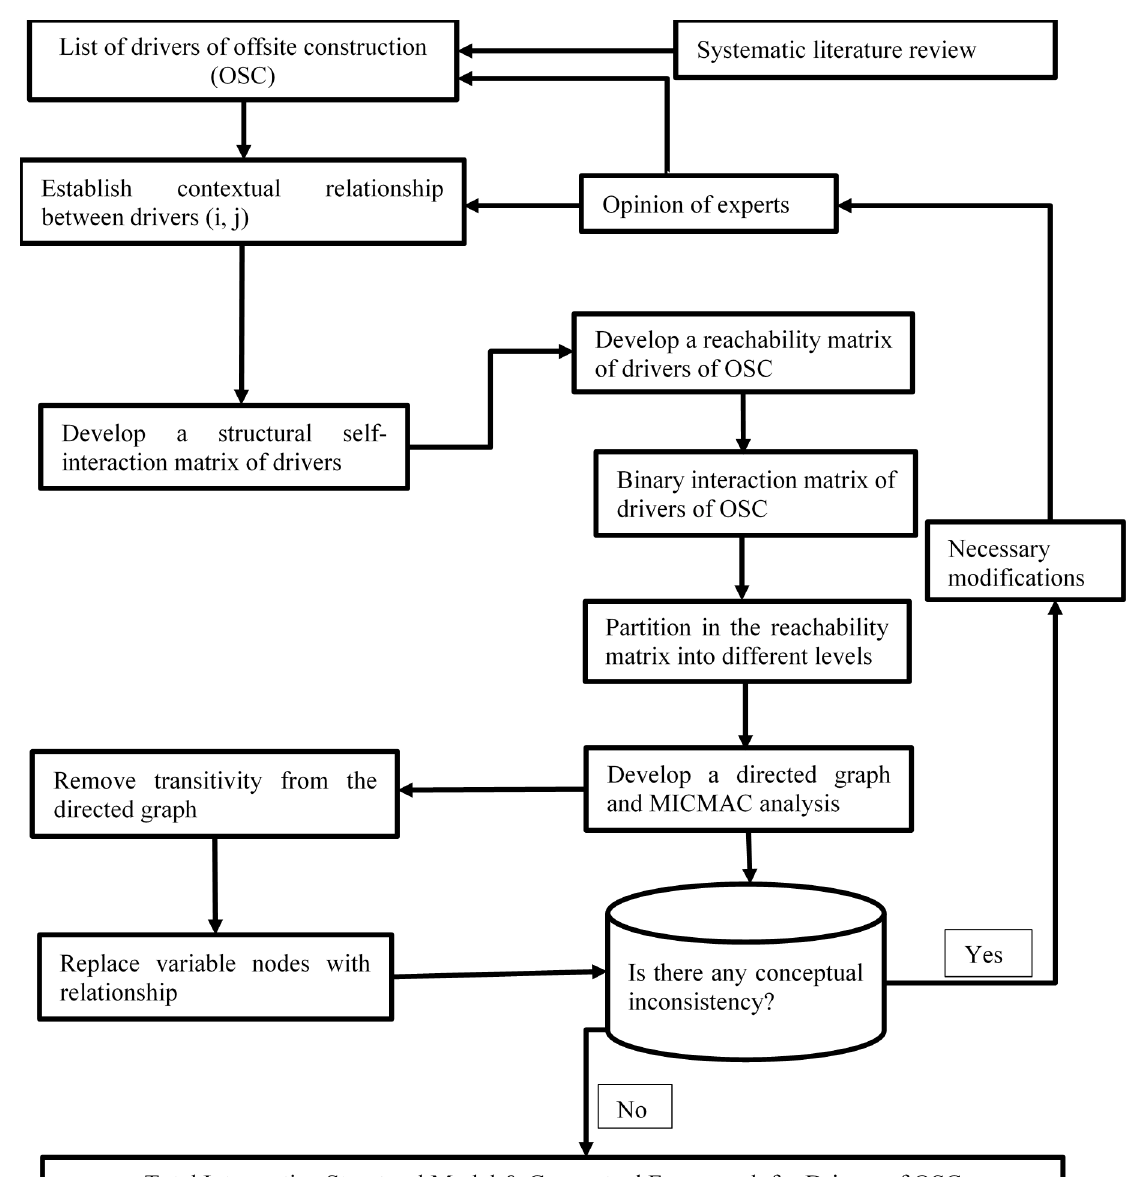
Figure 3. Total interpretive structural modelling procedure (adapted from [25]).